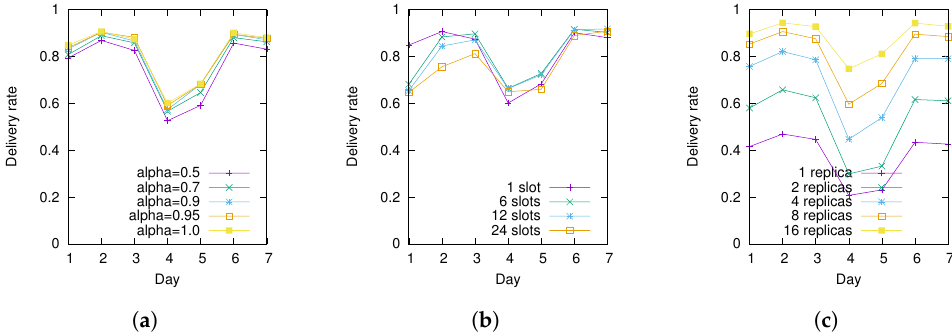
Figure 4. Learning model parameters’ impact on delivery rate. ( a ) Learning-rate parameter α ; ( b ) Number of time slots; and ( c ) Number of message